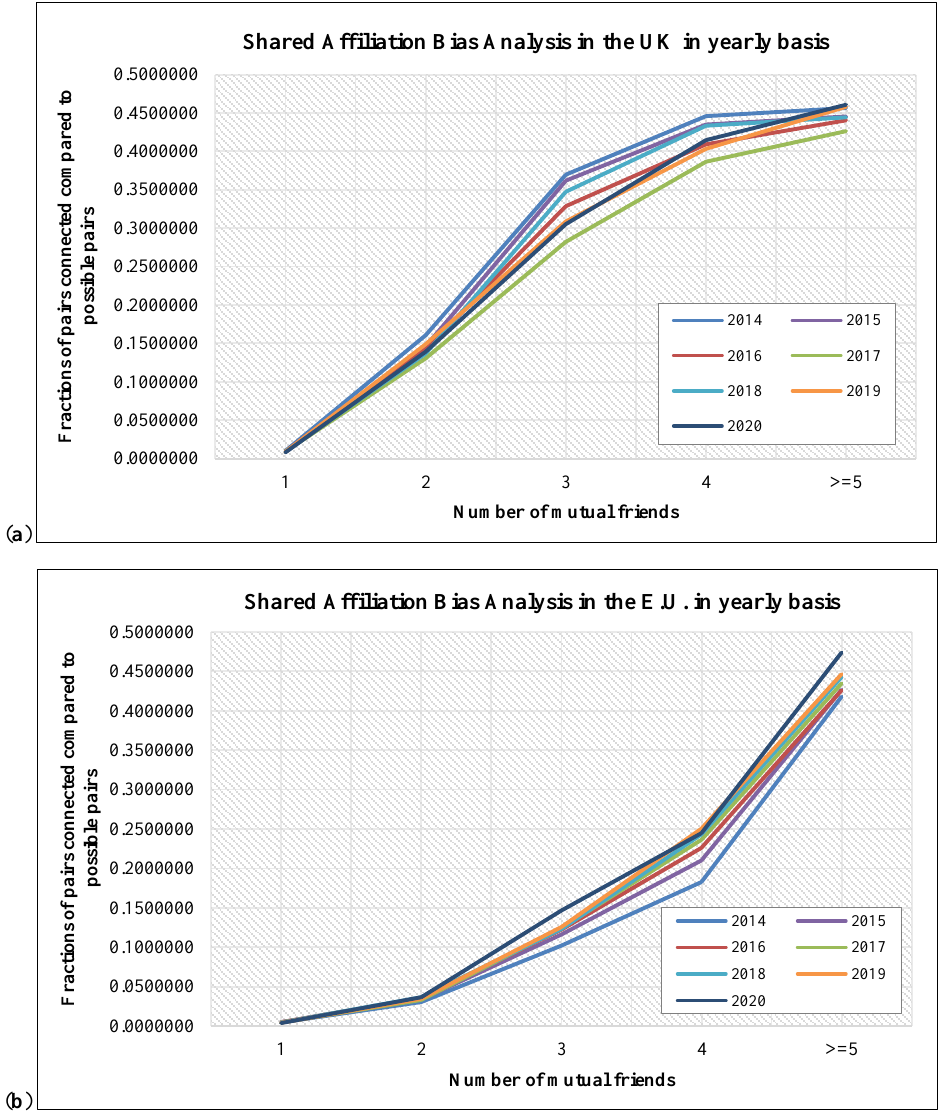
Figure 6. Comparison Analysis for Shared Affiliation Bias Analysis in yearly basis: (a) Shared Affiliation Bias Analysis in the UK; (b) Shared Affiliation Bias Analysis in the